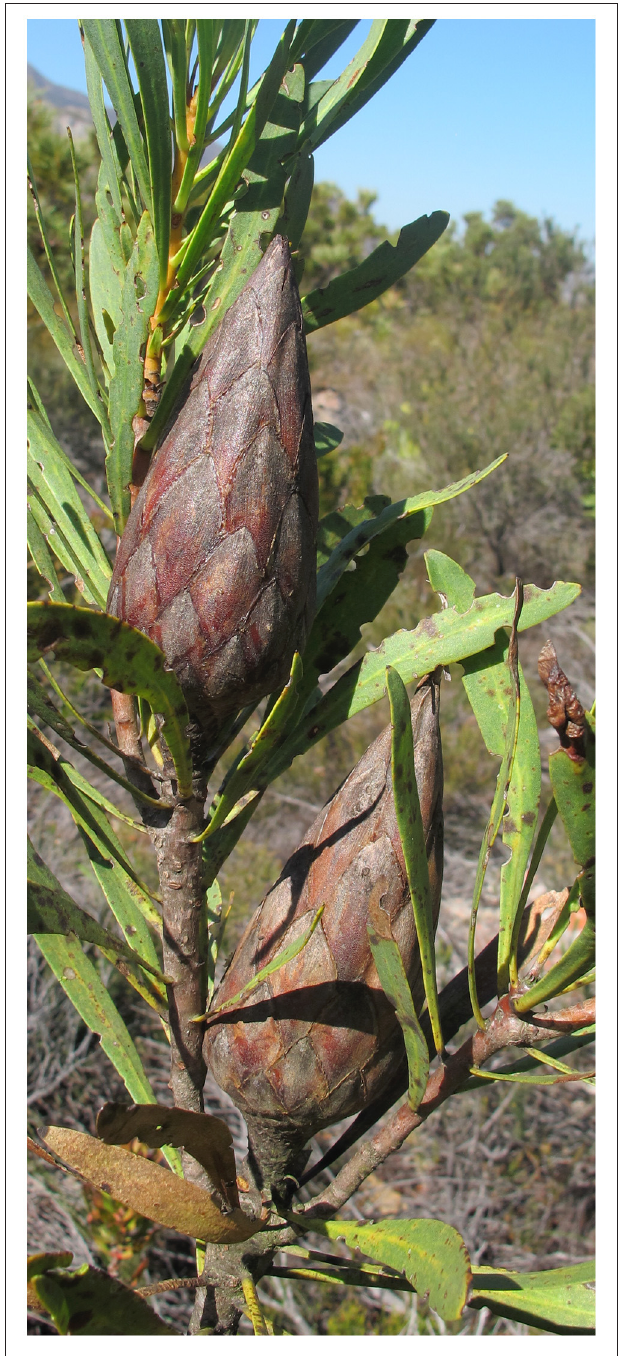
FIGURE 1 | A Protea repens branch with infructescences.